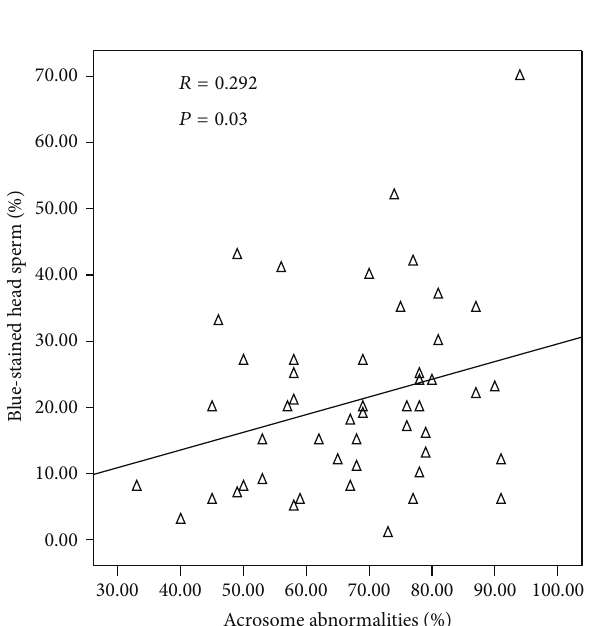
Figure 3: Correlation between sperm nucleus maturity and sperm head abnormalities. Table 3: Comparison between total motility, rates of normal morphology, and AB tingibility of sperm nuclear before and after sperm selection ( 𝑛 = 12 ).